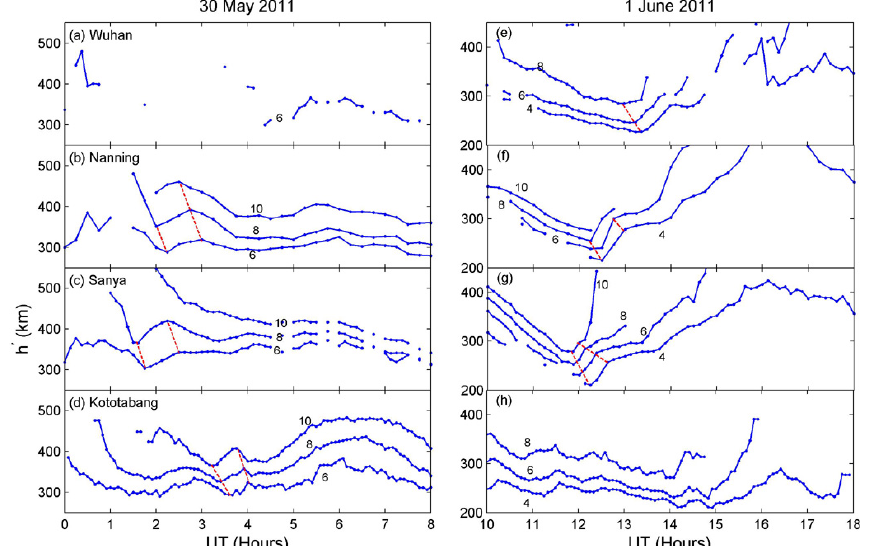
Fig. 7. Temporal variations in virtual height ( h 0 ) at detection frequencies ranging from 4 to 10MHz, in steps of 2MHz. The data were recorded by the ionosondes at Wuhan (30.5 ◦ N, 114.4 ◦ E), Nanning (22.8 ◦ N, 108.3 ◦ E), Sanya (18.3 ◦ N, 109.6 ◦ E), and an equatorial station at Kototabang (0.2 ◦ S, 100.3 ◦ E). The red dashed lines in each plot connect the peaks and valleys of the variations at different